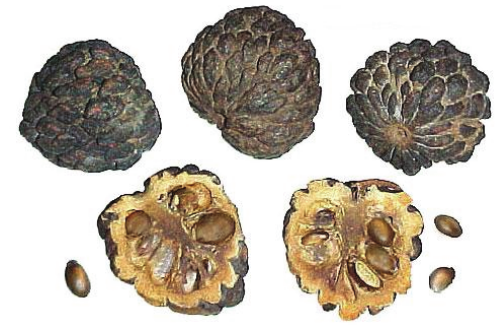
and USA, Hawaii and Florida. It was introduced to India and tury and has been cultivated there ever since [28].